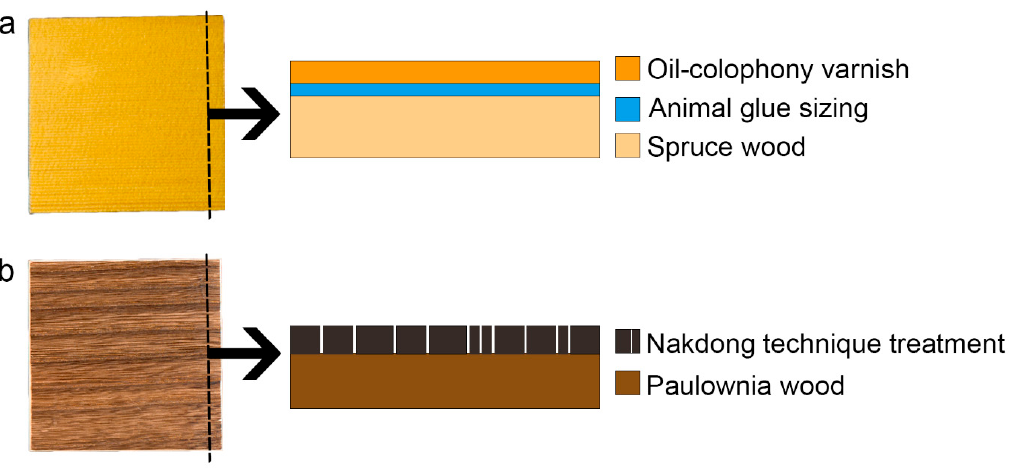
Figure 2. Schematic reconstruction of wooden mock-ups representative of ( a ) Western and ( b ) East Asian musical instrument finishing treatments.